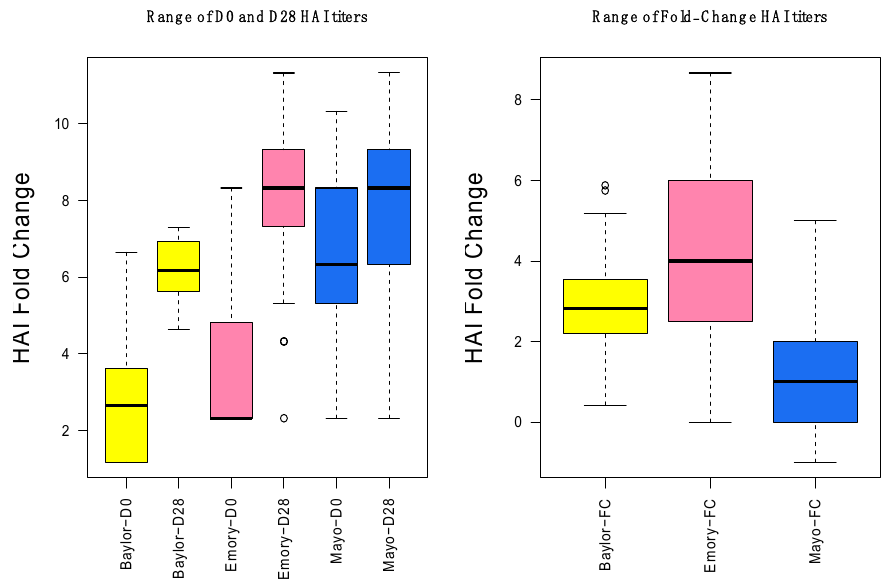
Figure 3. Range of day-0, day-28, and fold change HAI titers for the three data sets. The vertical axis shows the range of the HAI titers on a log 2 scale for all data sets. Fold changes for Mayo are lower because the population was older and had higher initial HAI.